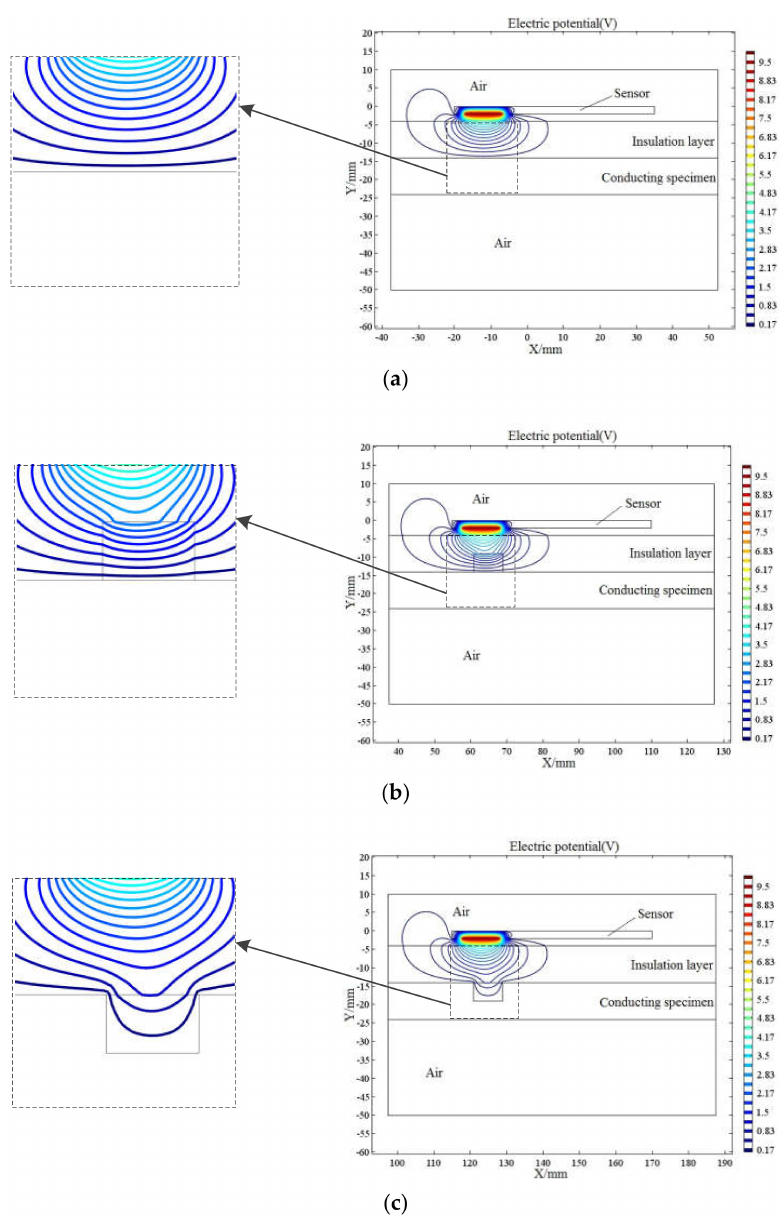
Figure 4. Electric potential diagrams of the multi-electrode sensor: ( a ) sensor inspecting the specimen without defects, ( b ) sensor inspecting a defect located in the insulation layer and ( c ) sensor inspecting a defect located on the surface of the conducting